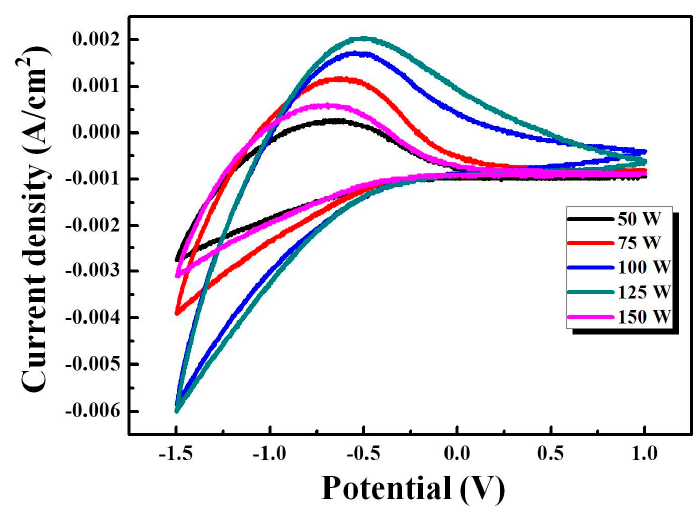
Figure 7. The 50th cycle CV curves of key factor IZTO films with various sputtering powers. Table 4. The diffusion coefficients of WO3/IZTO films at different sputtering powers.